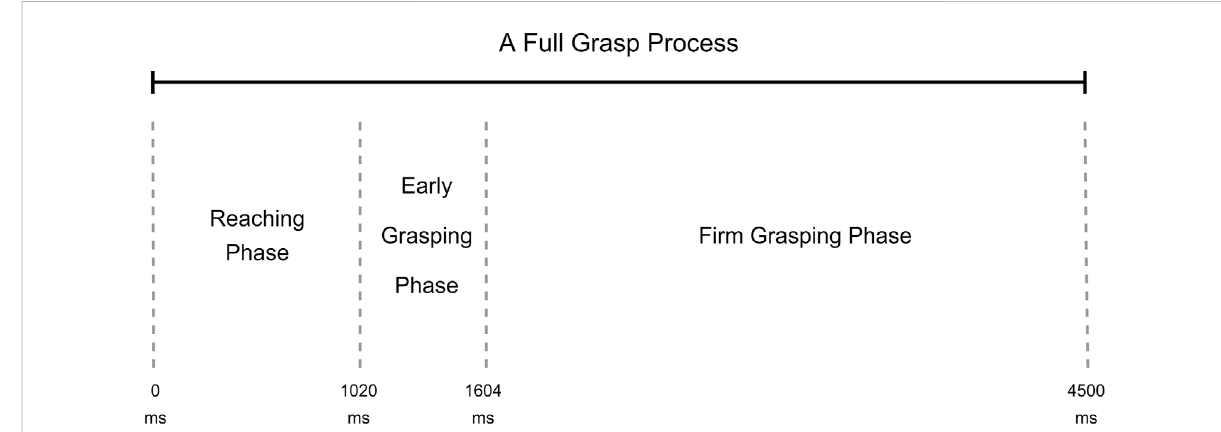
FIGURE 2 Example of grasp phases during a full grasp trial (Wang et al.,